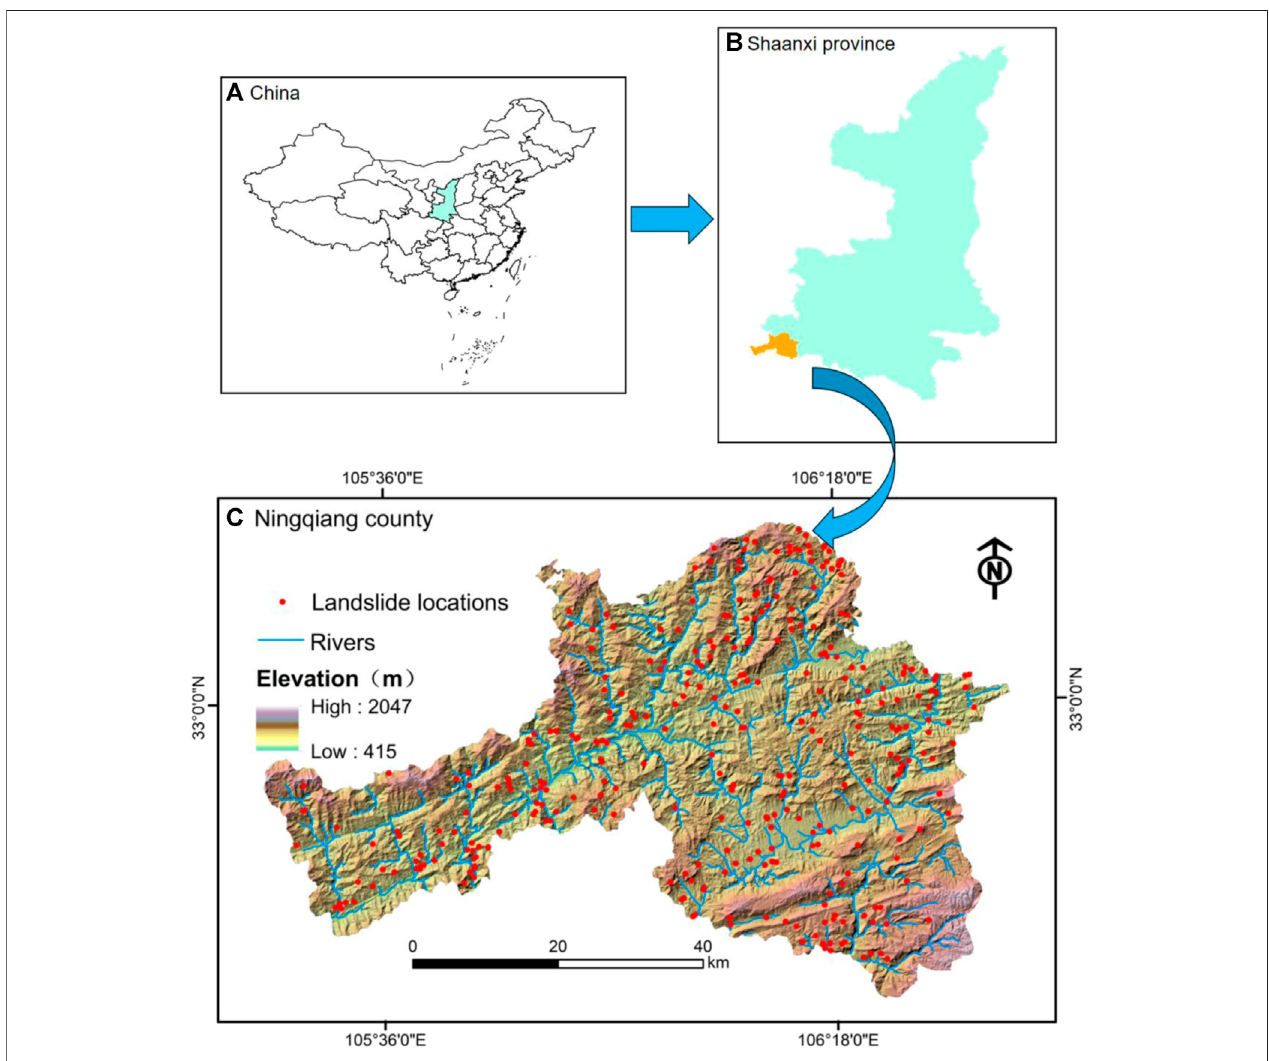
FIGURE 1 | The location of Ningqiang County, Shaanxi Province and distribution of landslides.